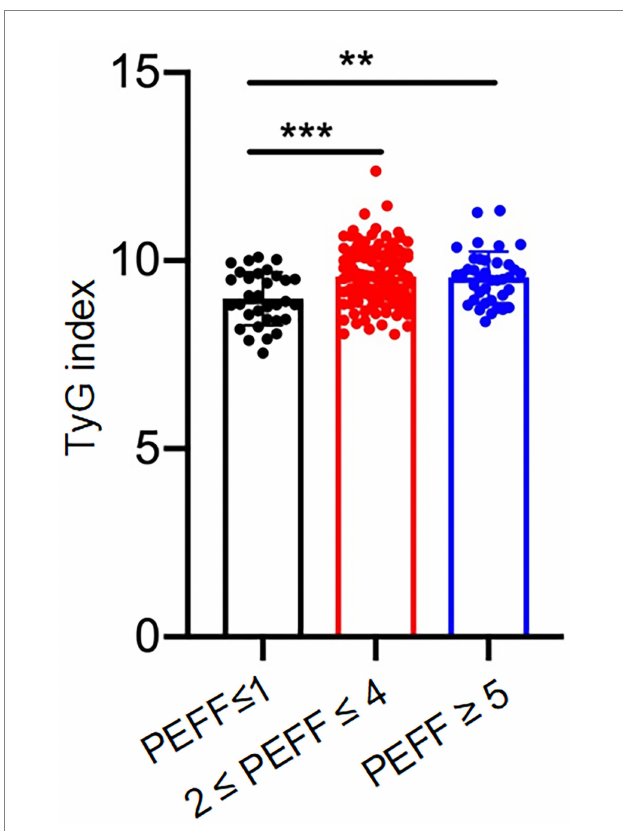
FIGURE 1 TyG index in diabetic patients stratified by HFA-PEFF score. ** p < 0.05. *** p < 0.001.